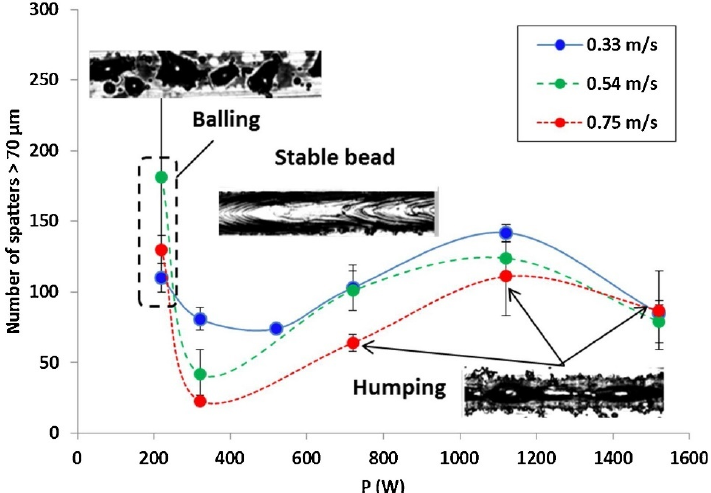
Figure 22. On a 316L stainless steel powder bed, the effect of laser power and scanning velocity on large-sized spatter, For low laser powers ( P = 220 W) and resulting VED values severe balling occurs, that generates important spattering. The lower amount of spatters is obtained for P values just above the balling threshold ( P = 320 W, V = 0.54 m/s and 0.75 m/s). (Reprinted with permission from Ref.